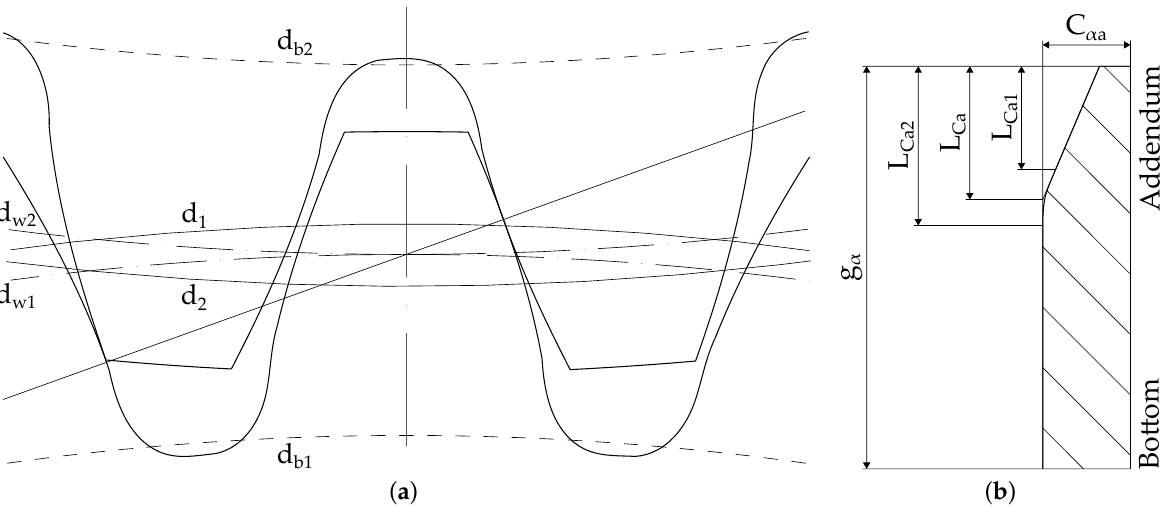
Figure 1. Gear pair used in the experiment. ( a ) Profile of the gear pair in transverse section. ( b ) Linear tip relief with parabolic transition.